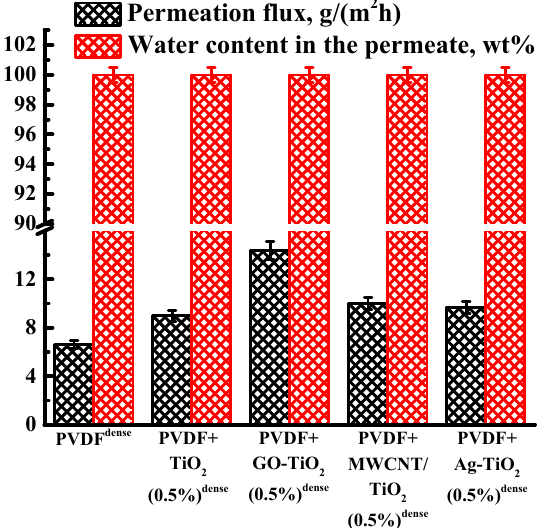
Figure 7. Permeation flux and water content in the permeate for dense membranes-based PVDF and PVDF/nanoparticle composites in pervaporation separation of a water/isopropanol (50/50 wt%) mixture at 22 °C.